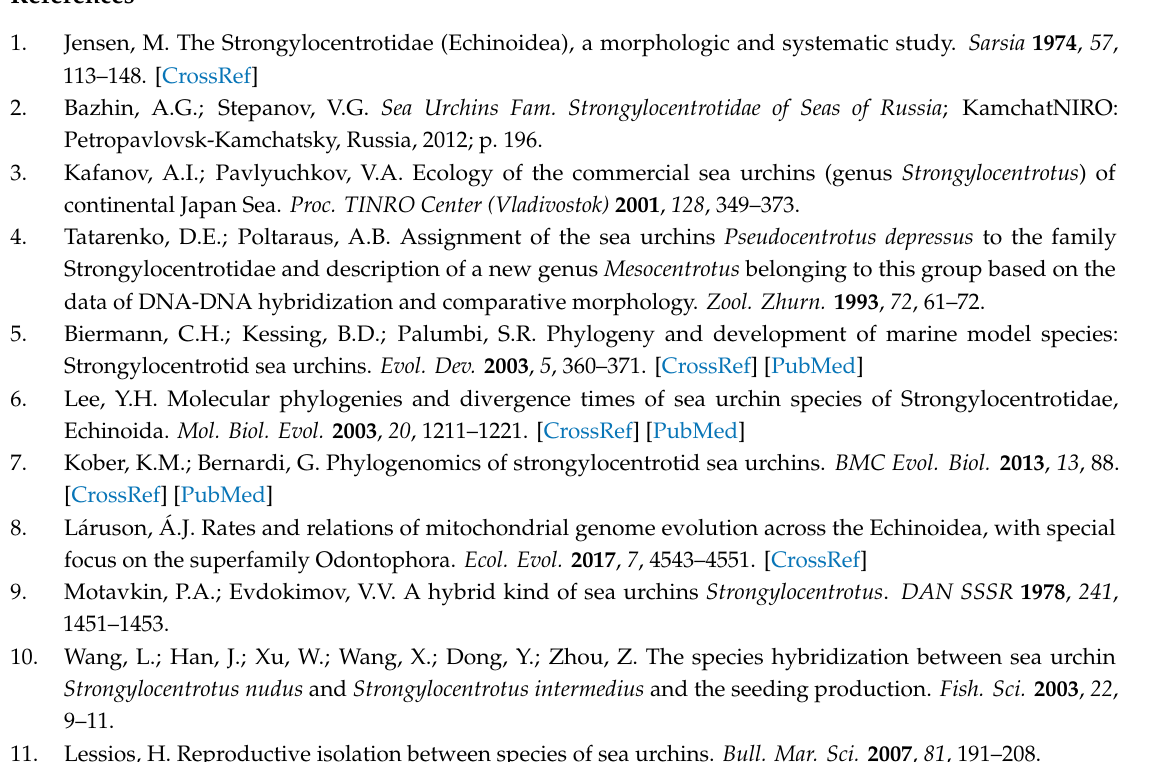
Figure S1. (DOC format: doc). Sea urchin ND6 protein alignment. Figure S2. (DOC format: doc). Short Read Archive sequence database search of the Strongylocentrotus intermedius and Mesocentrotus nudus transcriptomes. Table S1. (DOC format: doc). GenBank accession numbers. Table S2. (DOC format: doc). Sea urchin ND6 C-terminal sequences. DOI: 10.5281 /